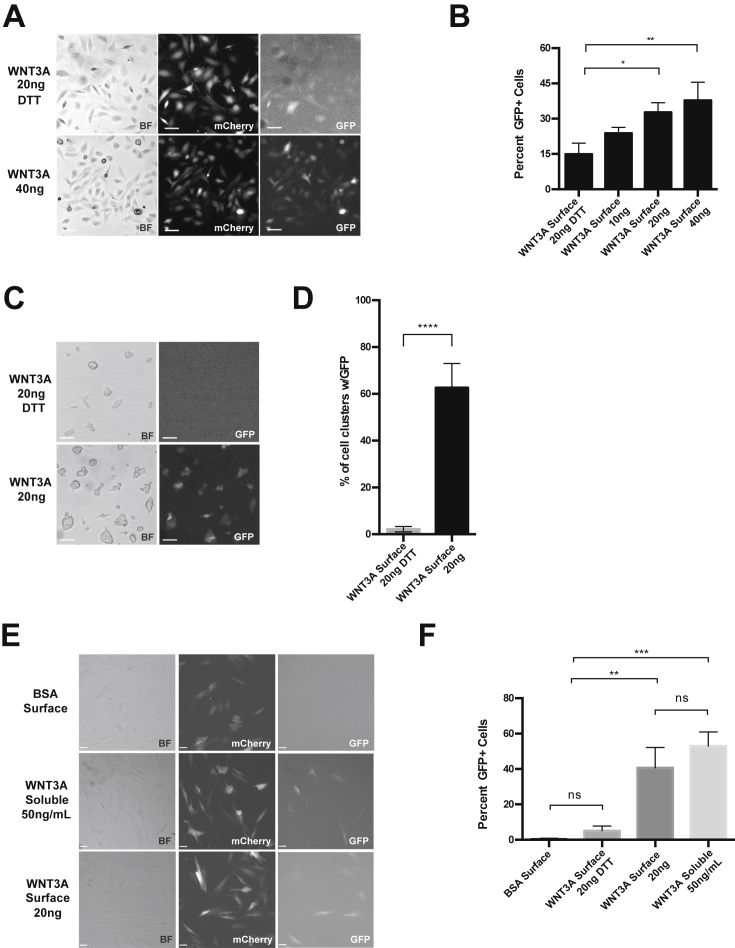
Immobilized WNT3A Surfaces Can Be Used to Induce WNT Signaling in a Variety of Stem Cell Cultures(A) Brightfield (BF) images of Comma Dβ-Geo cells on WNT3A immobilized surfaces with and without DTT treatment, along with corresponding mCherry (SV-40) and GFP (7xTCF) expression.(B) Percent GFP+ cells determined using automated protocol generated in Volocity software; based on finding overlap of mCherry and GFP objects. n = 4 independent experiments, mean ± SD; statistical significance determined with one-way ANOVA, ∗p < 0.05, ∗∗p < 0.01.(C) Brightfield images of 7TCF-eGFP mESC colonies and corresponding GFP expression.(D) Percent of GFP expressing cell clusters on WNT3A or DTT-treated surfaces. Number of colonies determined manually while GFP+ objects found using automated protocol generated in Volocity software. n = 4 independent experiments, mean ± SD; statistical significance determined by unpaired t test assuming equal SD; ∗∗∗∗p < 0.0001.(E) Brightfield images of hMSCs expressing 7xTCF-GFP/SV40-mCherry and the corresponding mCherry and GFP expression. Representative images from cells seeded on BSA control, BSA (supplemented with soluble WNT3A), or immobilized WNT3A.(F) The percent of GFP+ cells for each condition; determined using automated protocol generated in Volocity software; based on finding overlap of mCherry and GFP objects. n = 3 independent experiments, mean ± SD; statistical significance determined by two-way ANOVA; ∗∗p < 0.01, ∗∗∗p < 0.001; ns, not significant.The scale bar represents 50 μM.